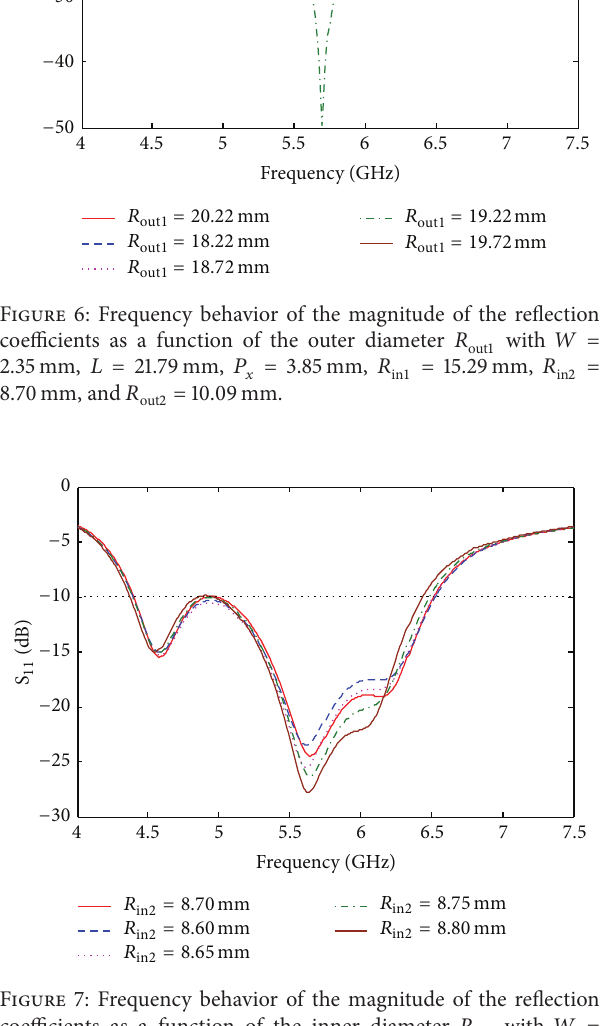
with 𝑊 = in 2 = 15.29 mm, 𝑅 = in 1 out 1